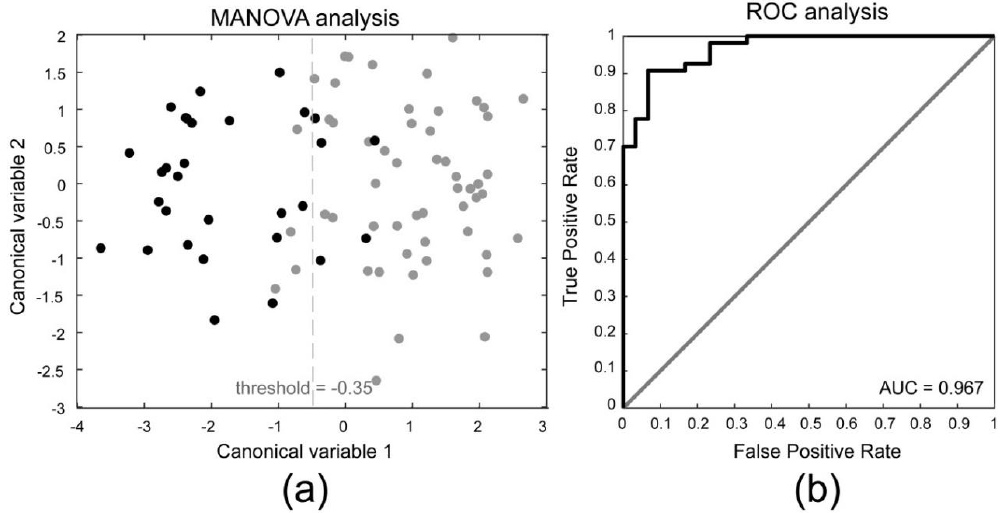
Figure 4. Results obtained when comparing subjects with ( n = 5) and without subclinical tendinopathy ( n = 9). ( a ) Representation of the subjects in the plane of the first two canonical variables obtained by a MANOVA analysis. The black circles represent the texture features of subjects with subclinical tendinopathy, while the gray circles represent the texture features of subjects without subclinical tendinopathy. The vertical gray dotted line represents the optimal threshold (maximum Youden index) used to obtain the sensitivity (93.3%), specificity (90.7%), and accuracy (91.7%) results; ( b ) ROC